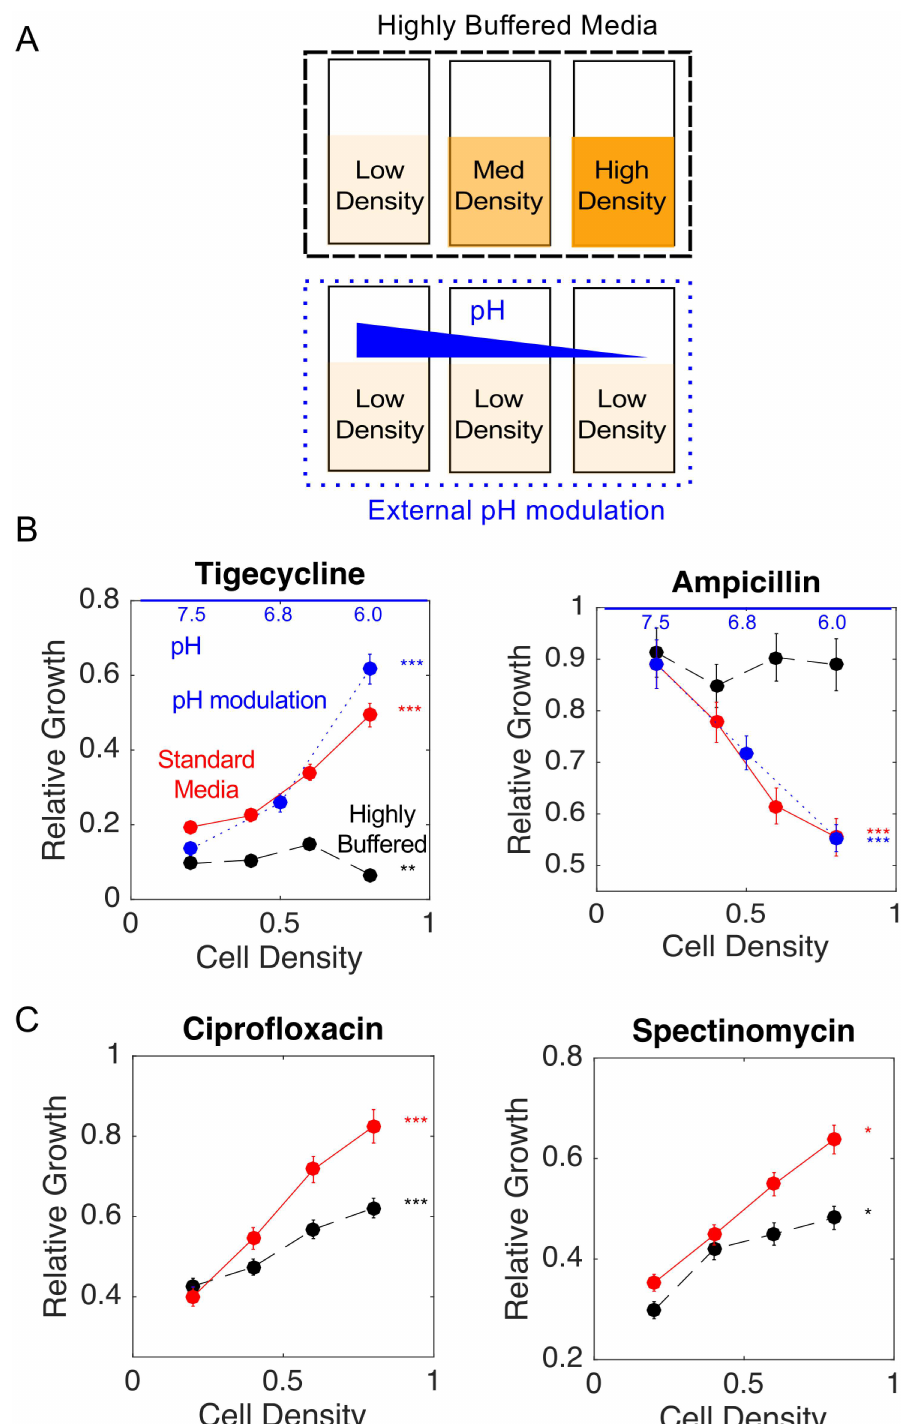
Fig 3. Density dependence of antibiotic inhibition partially due to local pH changes. A. Top row: Steady state populationgrowth was measured as a function of cell density (here schematically represented by low, medium, and high density) by holdingeach vial at a constant density while exposingcells to constant drug concentration in highly buffered media. Bottom row: Different culture vials were all held at low-density (OD = 0.2) but grown in BHI supplemented with HCl to achieve pH = 7.5, 6.8, and 6.0, which correspondto pH of steady state cultures held at OD = 0.2, 0.5, and 0.8, respectively. B. Red curves, regular media. Black dashedcurves, buffered media. Blue dotted curves, external pH modulation. Tigecycline concentration 50